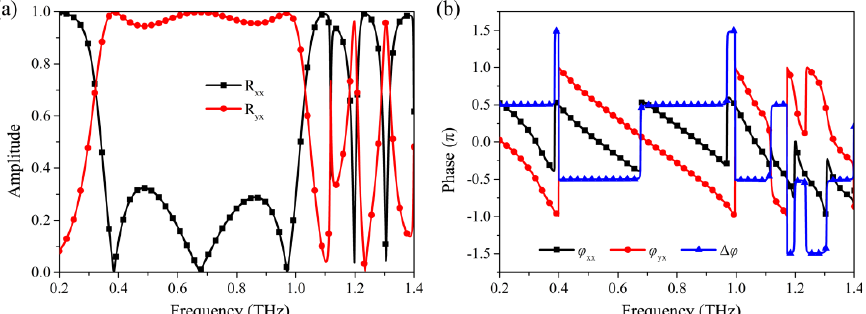
Figure 2. ( a ) The reflection spectra and ( b ) phase curves of the designed metasurface for incident x -polarized